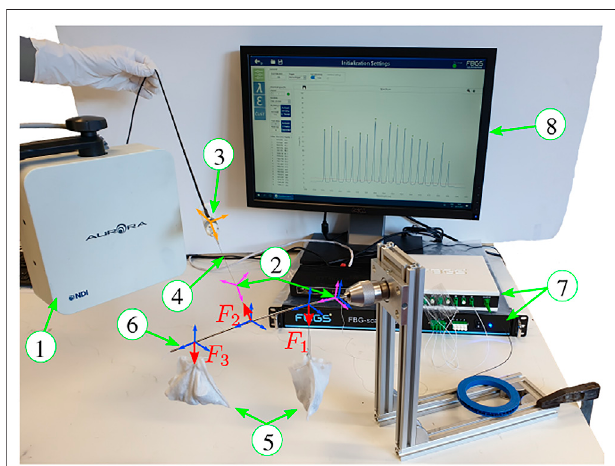
FIGURE 4 | Force estimation experimental setup comprising: ① electromagnetic (EM) fi eld generator, ② electromagnetic tracking (EM) sensors, ③ ATINano17sixDoFforcesensor, ④ tensionedcabletotransmita force to the Nitinol rod, ⑤ weights suspended by gravity, ⑥ Nitinol rod withan MCF embedded internally, ⑦ optical fanout and interrogator systems, ⑧ monitor to display wavelength spectra. Forces F 1 and F 3 are applied by suspending known weights, and force F 2 is applied along an adjustable direction by pulling on the ATI Nano17 six DoF force sensor which is attached to a cable that encircles the Nitinol rod.